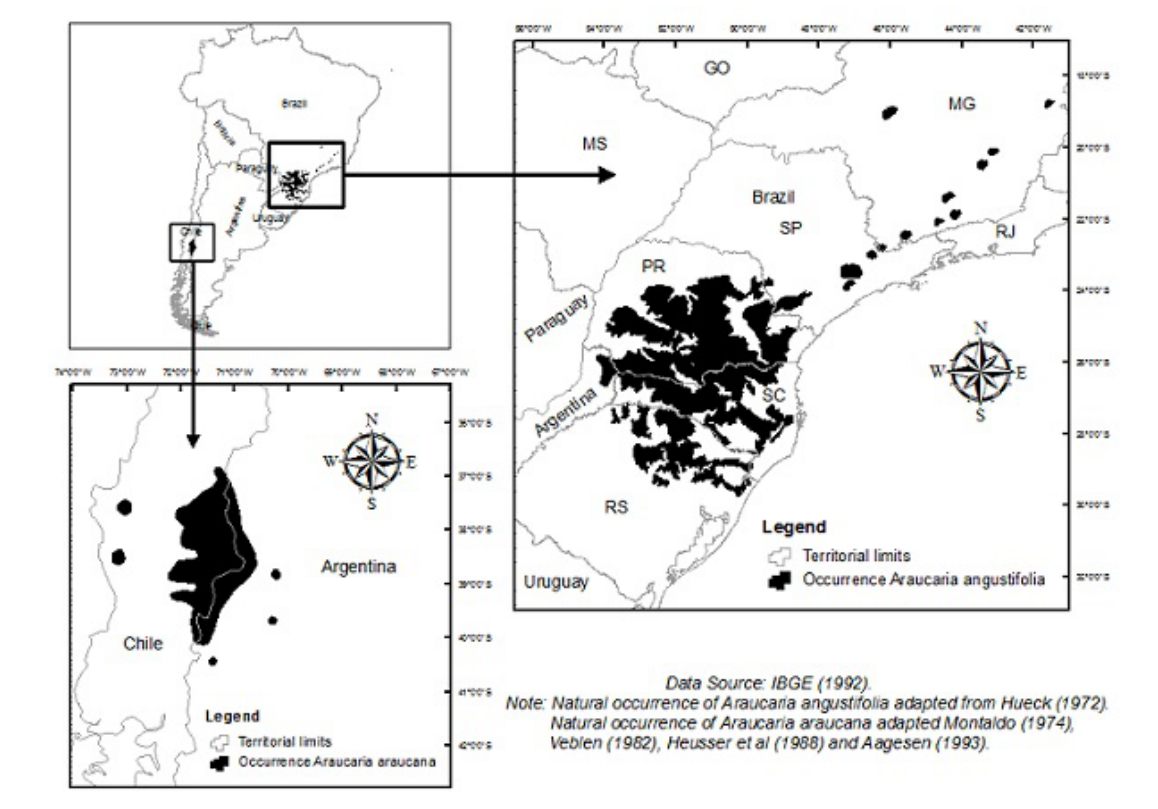
Fig. 1 . Distribution ranges of South American Araucaria ( Araucaria araucana in Argentina and Chile and A. angustifolia in Argentina and